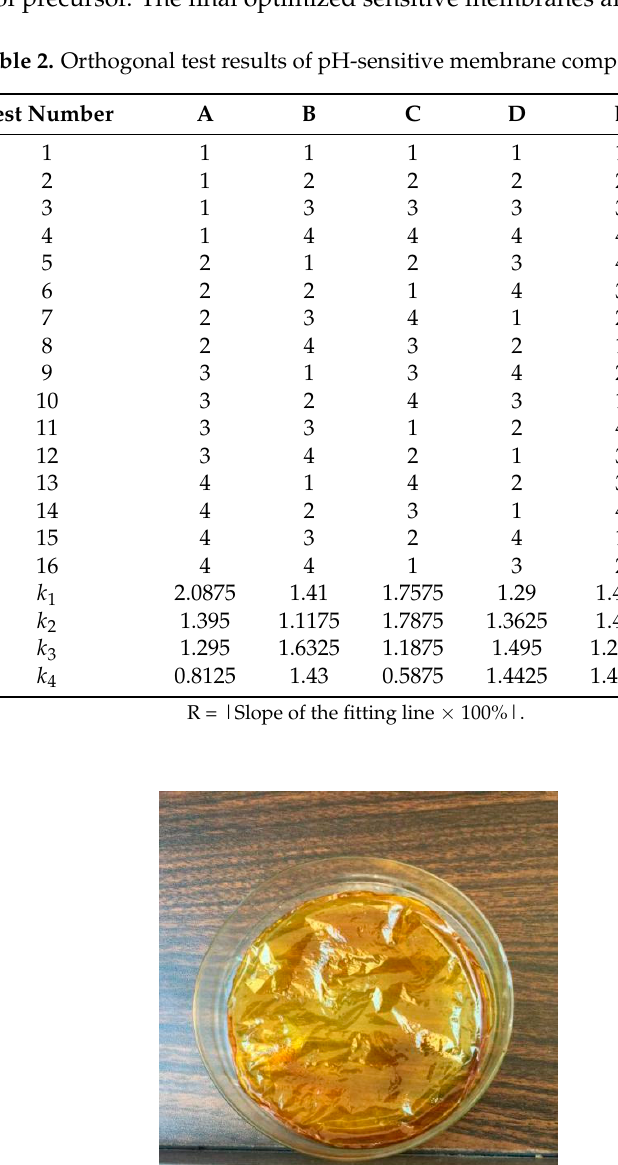
Table 2. Orthogonal test results of pH-sensitive membrane composition ratio.